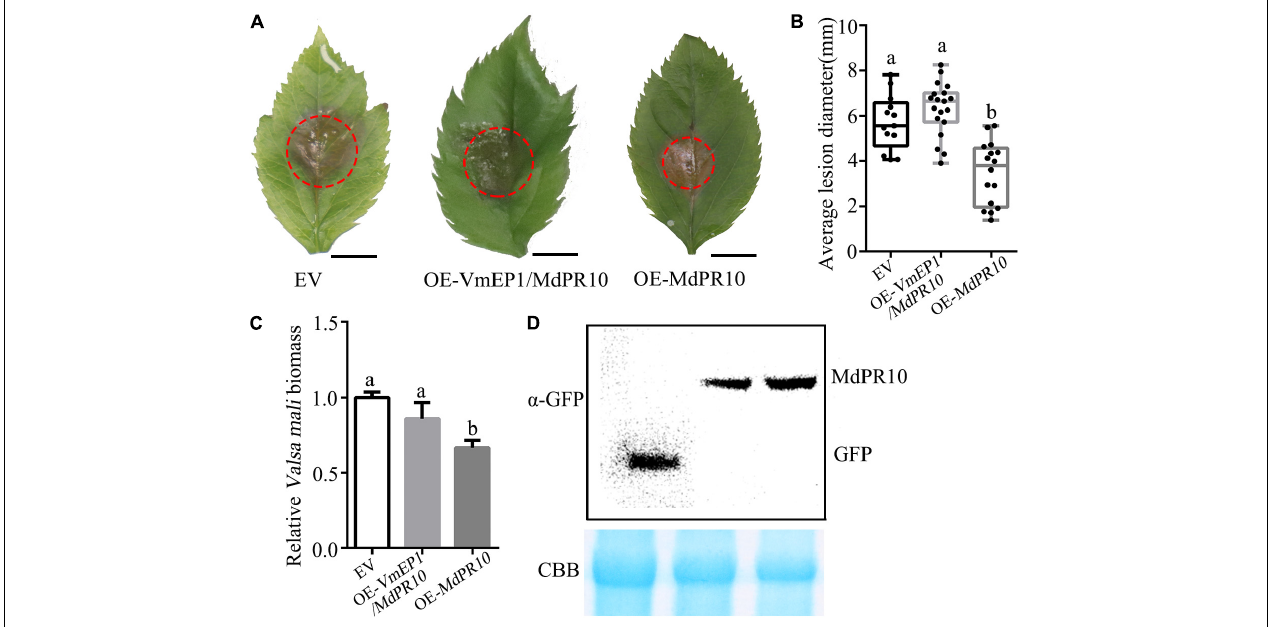
FIGURE 5 | A Valsa mali effector protein 1 attenuates the MdPR10-mediated resistance to V . mali . (A) Representative disease symptoms of the apple leaves overexpressing the genes at 36 hpi of V . mali . Bars = 5 mm. (B) The average lesion diameter in the apple leaves in which genes overexpression was evaluated at 36 hpi of V . mali . Means ± SDs; n > 15; a and b indicate t-test P < 0.05; Duncan’s multiple range test. (C) V . mali biomass was measured with qPCR at 36 hpi of V . mali . The relative V . mali biomasses were normalized to the mean of the control. Means ± SDs; n = 3; a and b indicate t-test P < 0.05; Duncan’s multiple range test. The genome DNA of apple leaves was extracted and the relative V . mali biomass was estimated by DNA-based quantitative PCR (qPCR). These experiments were repeated three times with similar results. (D) Immunoblot analysis of the expressed proteins were performed with anti-GFP antibody. CBB staining (bottom) was used as a loading